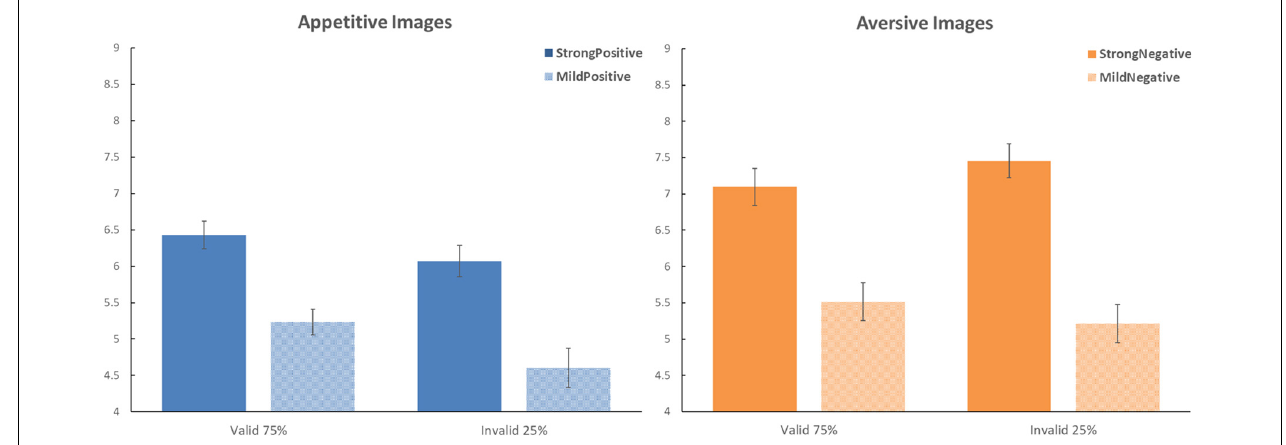
FIGURE 2 | Effects of predictive cues on the evaluation of food images in Experiment 2. Same format as in Figure 1 . In this experiment, the framing by the predictive cues correlated with the outcome; there was a 75% probability for the cue to be valid (i.e., matching valence with the outcome) versus 25% probability for the cue to be invalid (i.e., mismatching valence with the